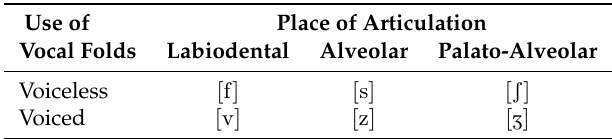
Table 1. Classification of European Portuguese fricatives by place of articulation and use of vocal folds. Use of Place of Articulation Vocal Folds Labiodental Alveolar Palato-Alveolar Voiceless [f] [s] [S] Voiced [v] [z]